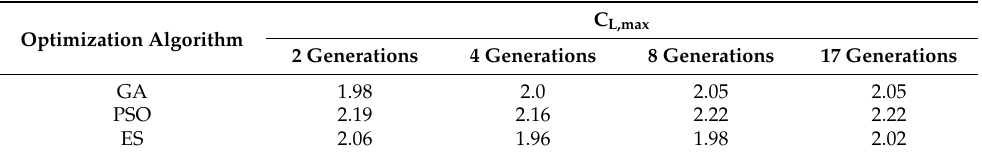
Table 3. Maximum lift coefficients of the airfoils generated using the three optimization algorithms for the more conservative design approach (up to 17 generations).